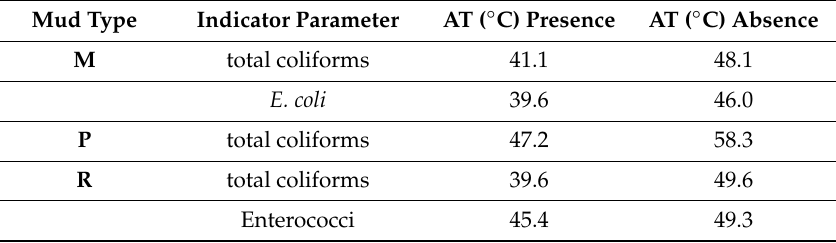
Table 11. Presence / absence of indicator parameters and average thermal water temperature. Average temperature (AT) for positive and negative samples is reported. Presence of indicator parameters ( > 0 CFU / g) always occurred in samples with an average lower thermal water temperature. M—maturing mud, P—peloid, R—regenerating used